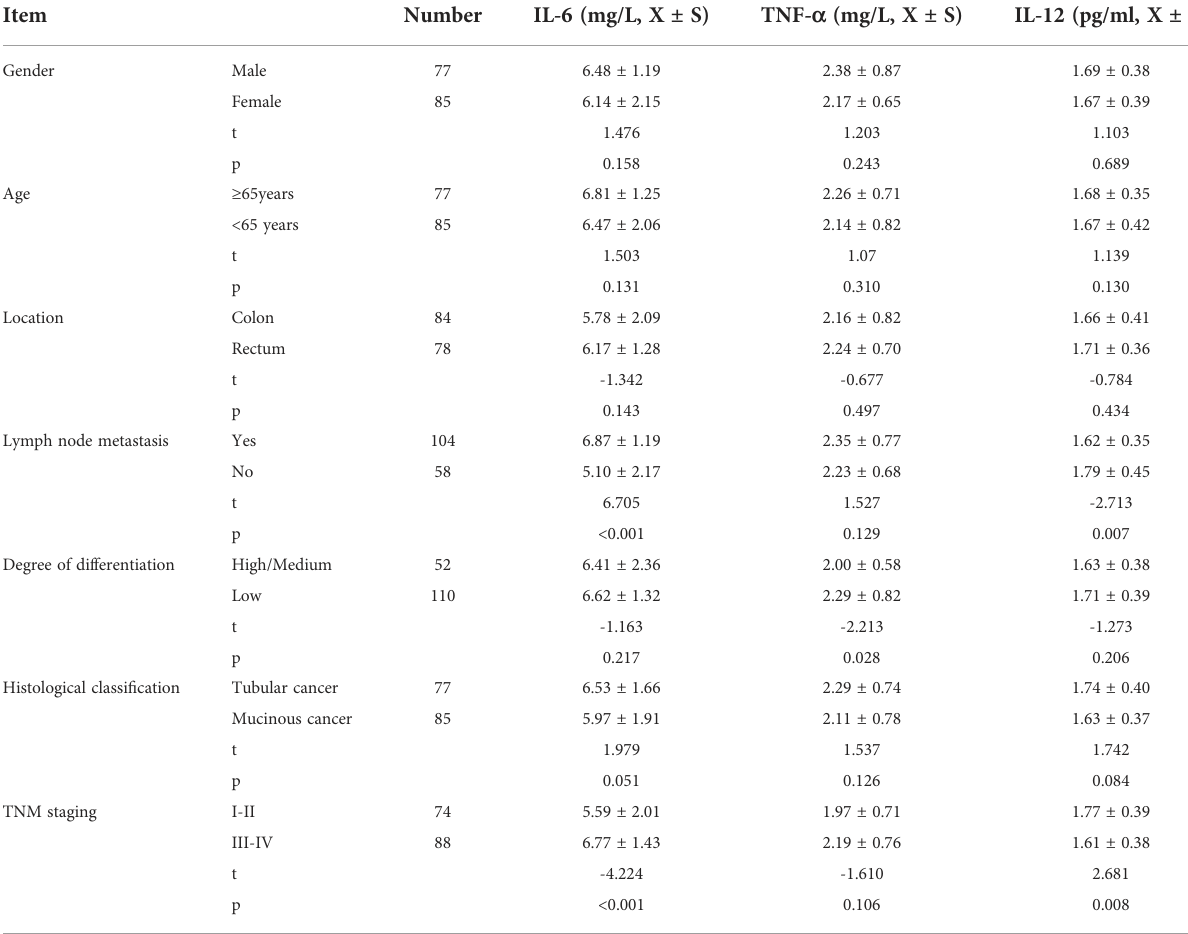
TABLE 1 The single factor analysis result of cytokine expression levels in patients with colorectal